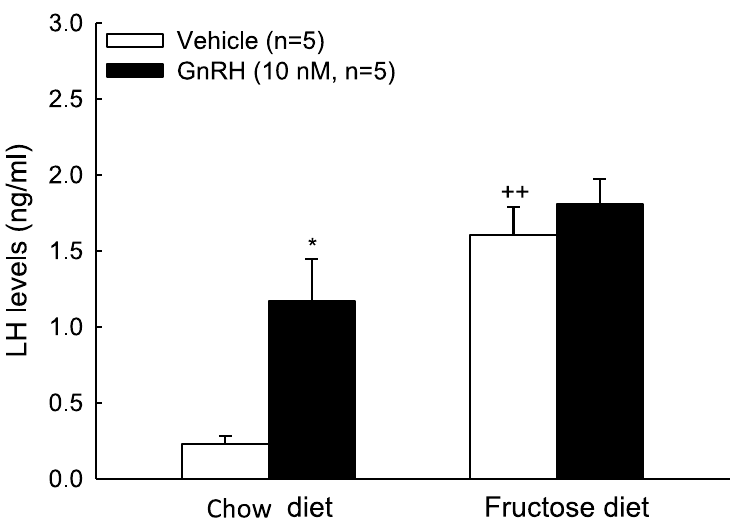
Figure 5. Effects of fructose-fed diet on LH release. Basal and GnRH-evoked LH release in rat AP tissues isolated from fructose-diet fed group (black column) and control group (white column). * p < 0.05 as compared to the control group. ++ p < 0.01 as compared to the chow diet group. Each value presents mean ± SEM. Similar results were repeated twice.